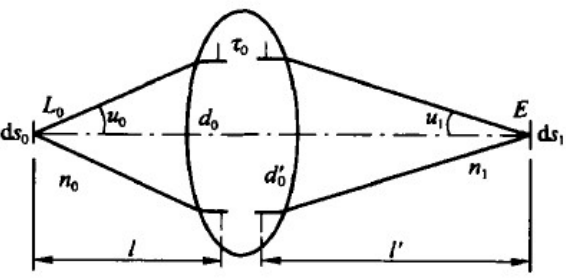
Figure 5. Optical path diagram of the TMISs.